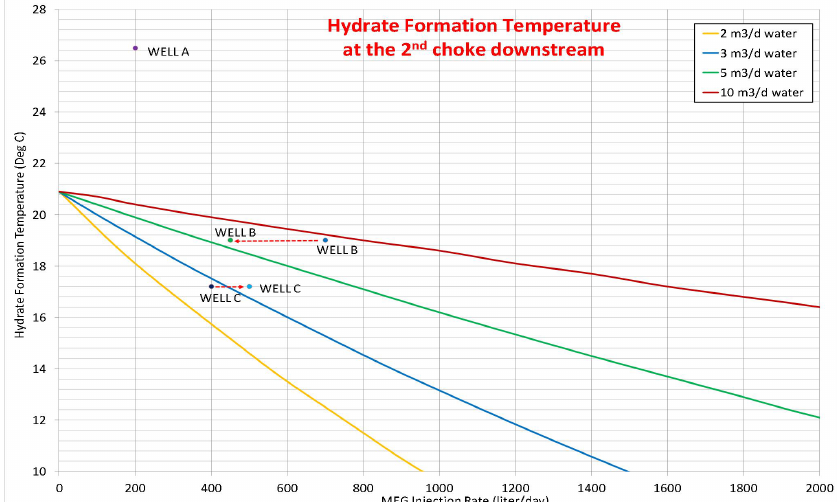
Figure 11—Sour gas hydrate formation temperature at the second choke downstream at fixed pressure and various MEG injection